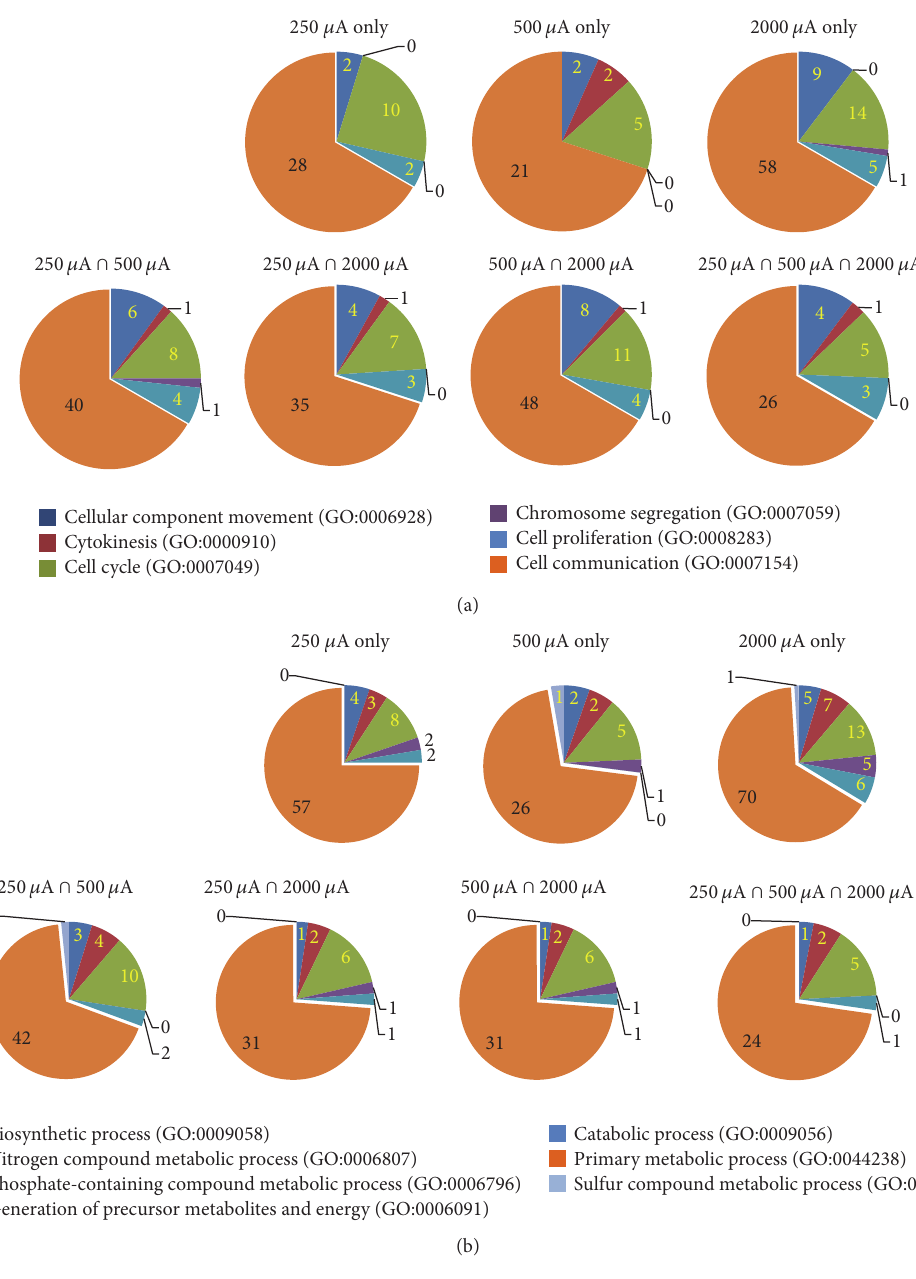
Figure 5: Two largest categories of gene ontology (GO) functional biological process analyses. (a) Six subcategories were identified from the cellular category. (b) Seven subcategories were identified from the metabolic process